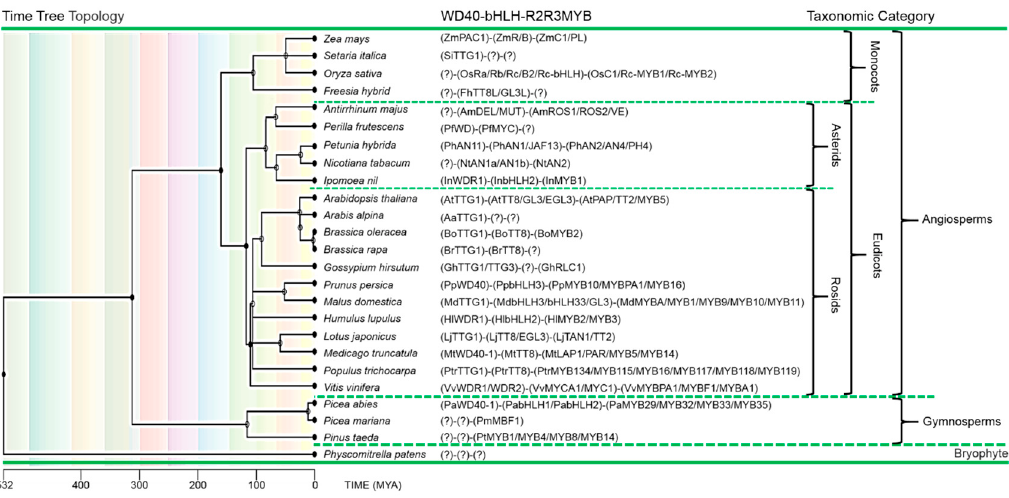
Figure 6. MBW proteins are common and conserved modules involved in regulating flavonoid biosynthesis throughout the plant kingdom. The phylogeny of selected land plants is reflected by time tree topology on the left (TimeTree (left) generated using the TimeTree database (www.timetree.org) [159]). Functionally-characterized MBW proteins from different plant species are listed in the middle (flavonoid pathway exclusive). Question marks indicate unidentified components. For a full list of proteins and references, please refer to Table 2.